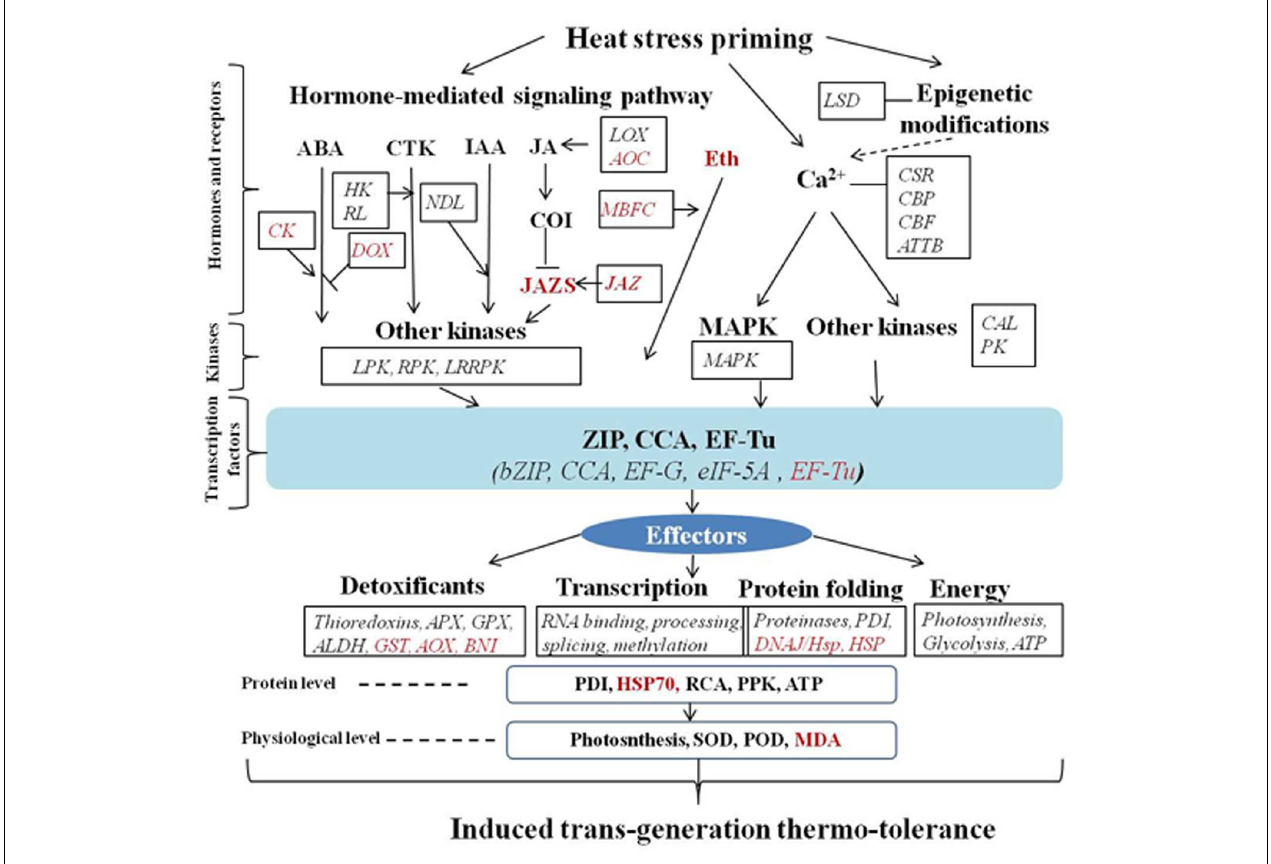
FIGURE 3 | The proposed mechanism of trans -generational tolerance to the high-temperature stress during grain filling in the progeny of primed plants. The transcriptome physiological analysis suggested that the induced heritable thermo-tolerance by priming the parent generation could activate the processes of epigenetic processes and signaling transduction pathways, which further triggered the modifications of stress defense related processes of defense, transcription, energy, and protein destination and storage in the progeny of primed plants under the reoccurring high-temperature stress. At the proteome level, protein abundance of photosynthesis and energy, and PDI were also up-regulated in the progeny of primed plants compared to non-primed plants in responding to the high-temperature stress, which led to the better maintenance of leaf photosynthesis and activities of photosynthesis and anti-oxidation enzymes, lowered cell membrane damage level and improved heat stress tolerance in progeny of primed plants (italic red means down-regulated, italic black means up-regulated). ALDH, aldehyde dehydrogenase; AOC, allene oxide cyclase; APX: ascorbate POD; ATTB, aldolase-type TIM barrel family protein; bZIP, basic-leucine zipper transcription factor family protein; CAL, concanavalin A-like lectin protein kinase family protein; CBF, calcium-binding EF hand family protein; CBP, Ca 2 + -binding protein; CCA, circadian clock associated 1; CK, casein kinase 1-like; CSR, calcium sensing receptor; DOX, alpha dioxygenase; EF-G, translation elongation factor EFG/EF2 protein; EF-Tu, elongation factor Tu family protein; eIF-5A, eukaryotic elongation factor 5A-3; GPX, glutathione POD; GST, glutathione S -transferase family protein; HK, histidine kinase; JAZ, jasmonate-zim-domain protein 1; LOX, lipoxygenase; LPK, lectin protein kinase family protein; LRRPK, leucine-rich receptor-like protein kinase family protein; LSD, lysine-specific histone demethylase 1; MBFC, multiprotein bridging factor 1C; NDL, N-MYC downregulated-like 1; PDI, pyridine nucleotide-disulphide oxidoreductase family protein; PK, protein kinase superfamily protein; PRK, phosphoribulokinase; RA, rubisco activase; RL, ribosomal protein L6 family; RPK, receptor like protein